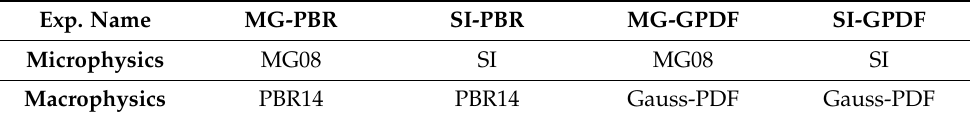
Table 1. Numerical experiments to evaluate the micro- and macrophysics